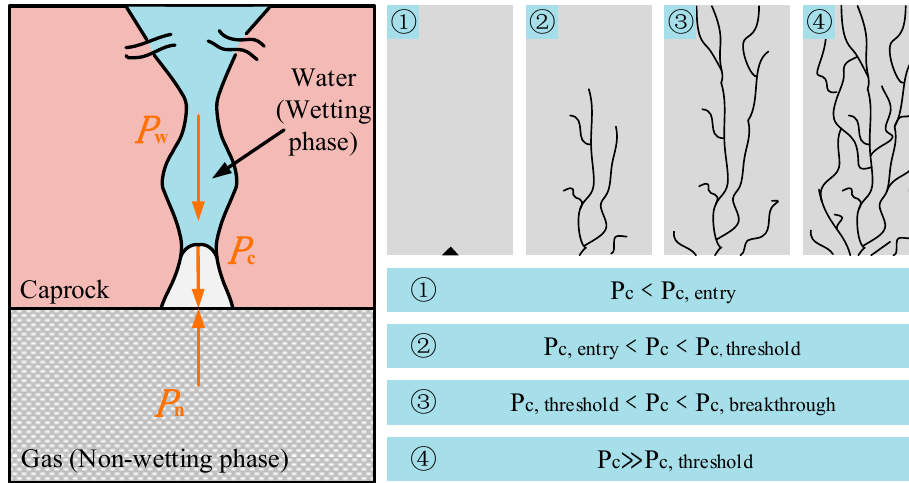
Figure 1. Mechanism of gas breaking through caprock [20].